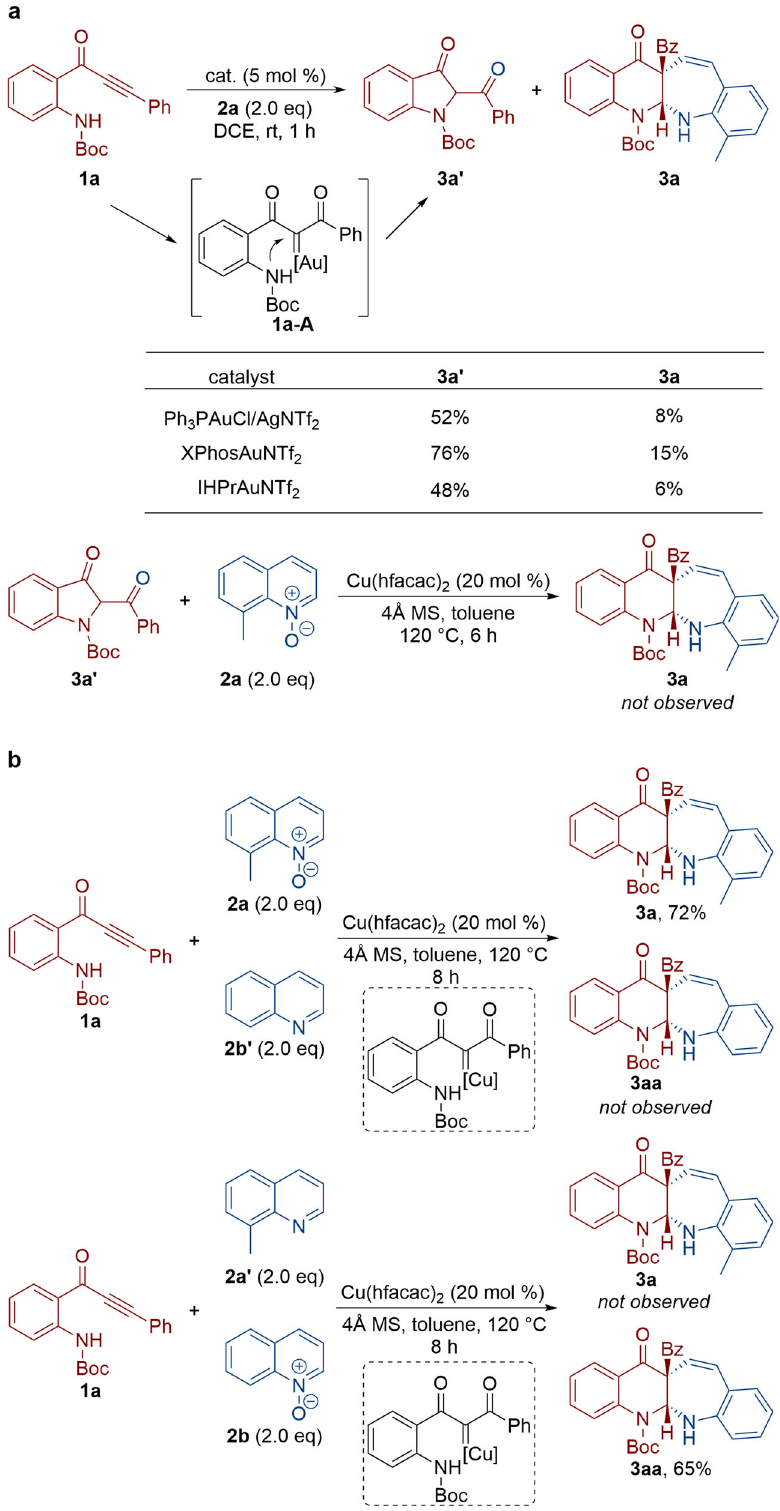
Fig. 7 Control experiments. a Typical noble-metal catalysts were tested. b A 1:1 mixture of quinoline N -oxide and quinoline was